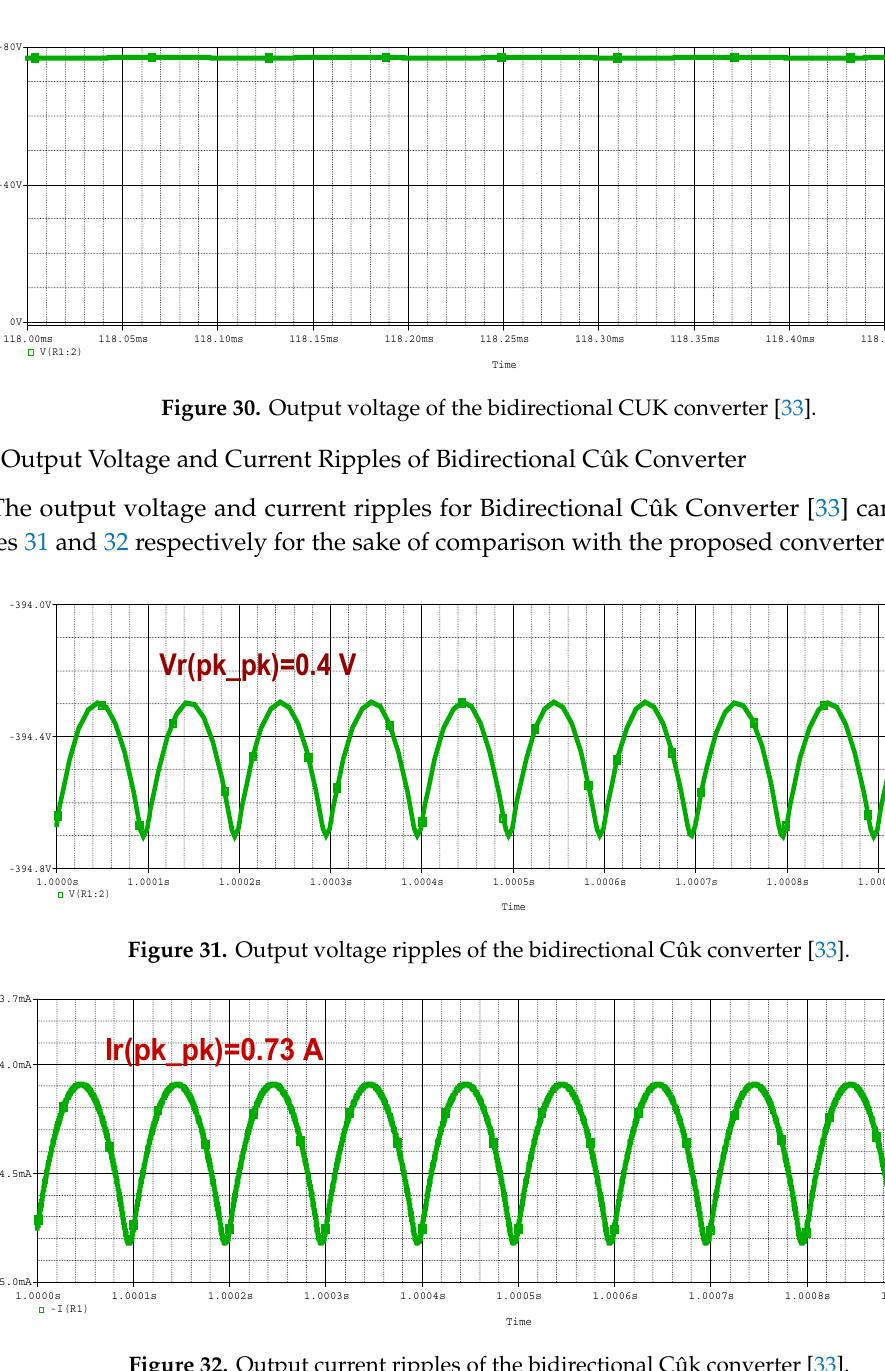
Vs Figure 29. Voltage across switch “s” of the conventional boost converter [28]. 6.4.4. Output Voltage of [Bidirectional C ûk Converter ] for a 50% Duty Cycle